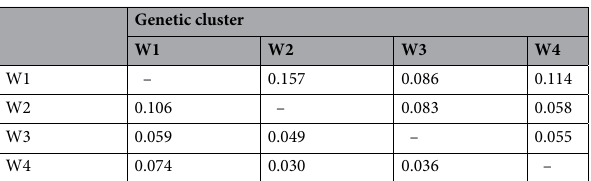
Table 1. Pairwise values of F st (below diagonal) and D est (above diagonal) among genetic clusters of red- fronted macaw in the wild. All estimated values are significant ( P < 0.01).